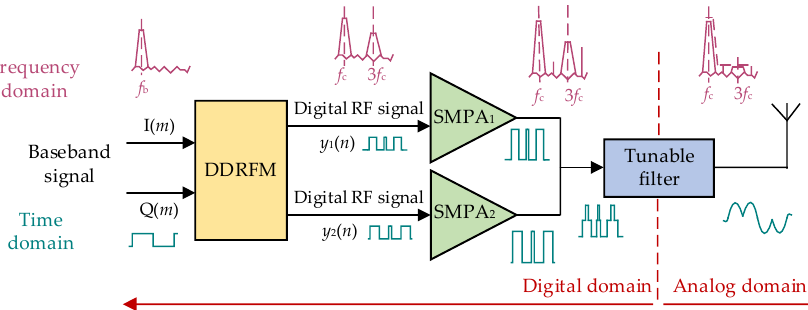
Figure 1. Structure diagram of ADTx system based on phase-shift control.